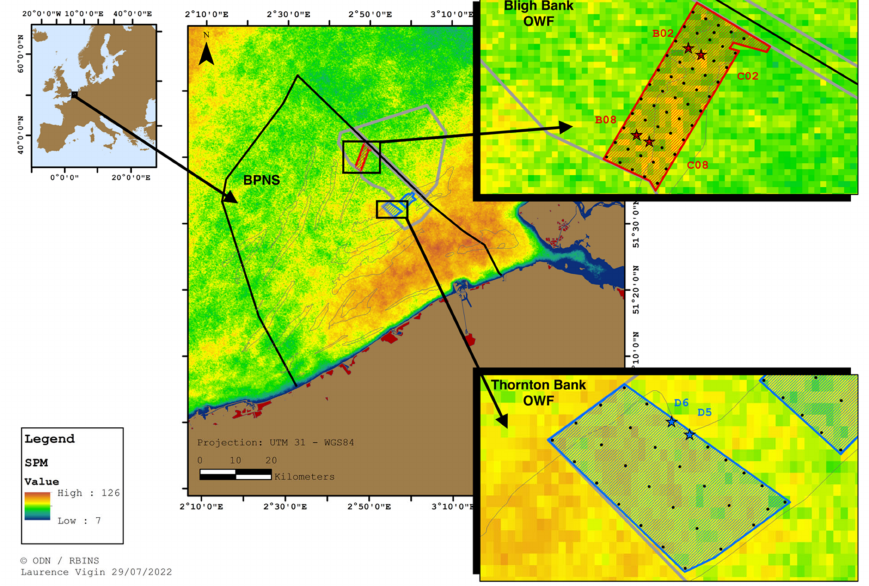
Figure 1. Map of the Belgian part of the North Sea (BPNS: black polygon) showing the sampling locations and their position relative to Belgian and Dutch offshore wind farm (OWF) zones (grey polygons). The Bligh Bank OWF is represented in red and the Thornton Bank OWF is represented in blue. The sampled turbines are marked with a star. Mean annual surface suspended particulate matter (SPM) concentration derived from the Ocean and Land Colour Instrument as in